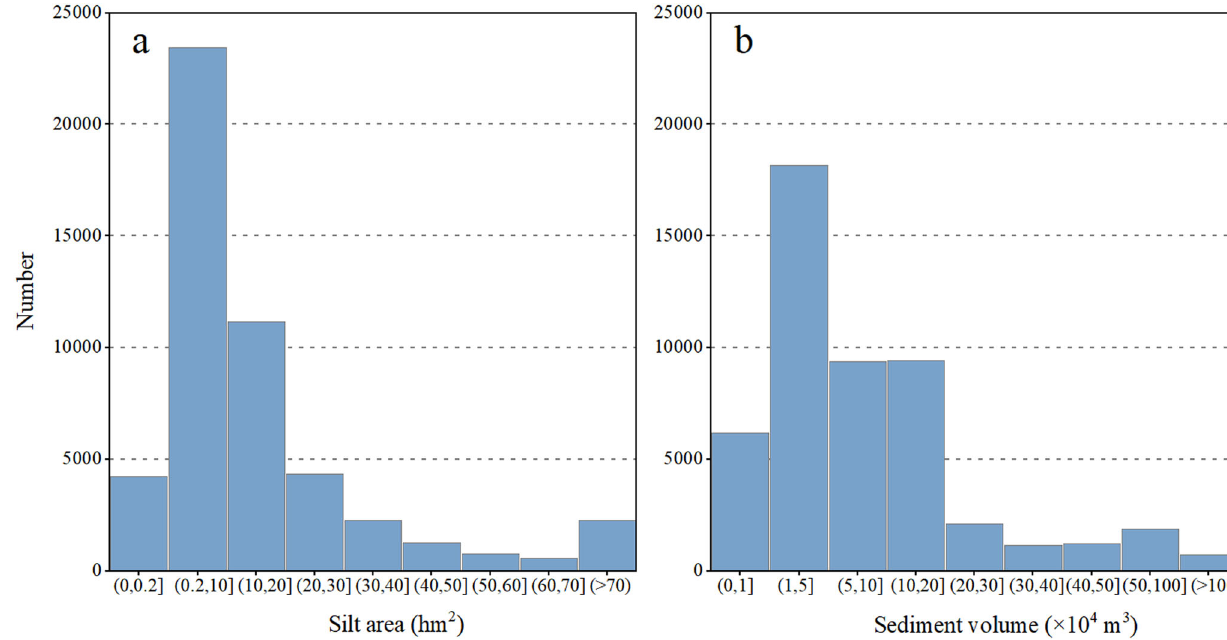
Fig. 2 Quantitative distribution characteristics of check dams on the Chinese Loess Plateau. a Frequency distribution of silted area. b Frequency distribution of sediment volume.